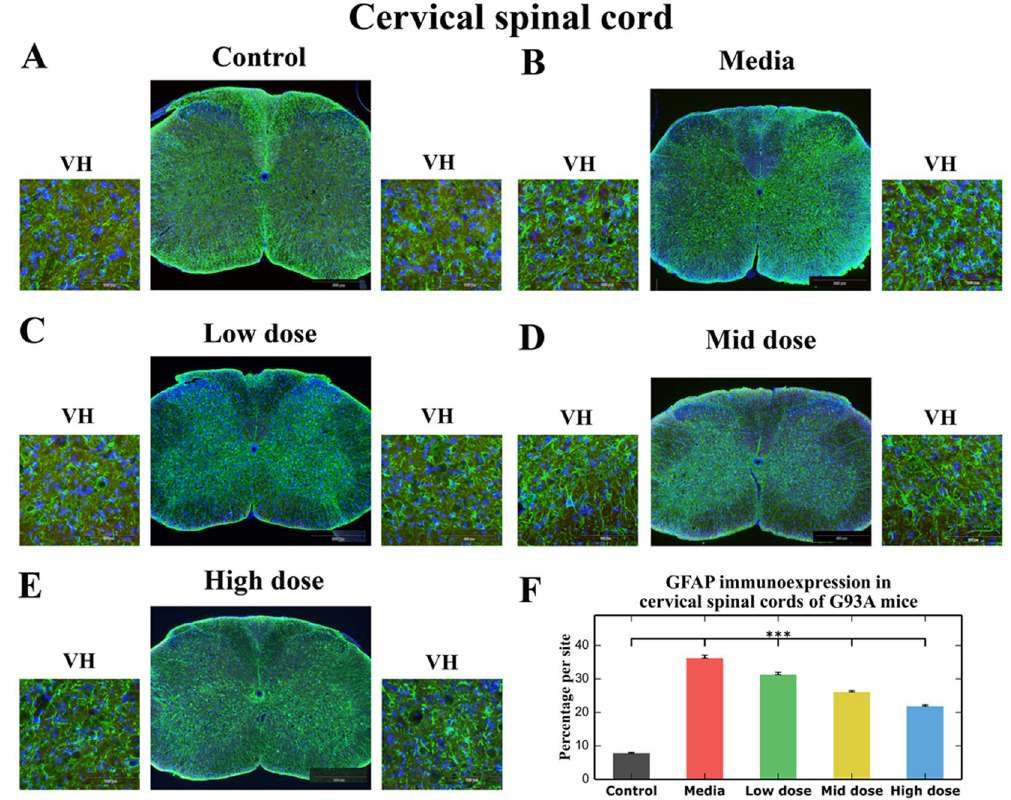
Figure 4. Characteristics of protoplasmic astrocytes in the cervical spinal cord of G93A mice. Immunohistochemical staining of astrocytes using GFAP antibody (green) in ( A ) control mice showed cells with normal cellular morphology distributed relatively uniformly within spinal cord gray matter. ( B ) At 17 wks of age, astrocytes with large cell bodies and hypertrophic processes at high density were determined in media-injected mice. ( C ) Moderate decrease of reactive astrocytes was noted in the ventral horns of ALS mice treated with low cell dose. ( D ) Less astrocyte cell reactivity and more astrocytes with thin cell processes were seen in the gray matter of ALS mice with mid dose. ( E ) Only a few astrocytes with thick cell processes and enormous cell bodies were found in mice after high cell dose transplantation. In these mice, more astrocytes with typical cellular morphology were noted. Scale bar in A-E for full coronal spinal cord section is 500 µ m and in ventral horn insert is 100 µ m. ( F ) Quantitative analysis of GFAP immunoexpression in the cervical ventral horn demonstrated significantly higher astrocyte density in media-injected mice vs. controls of the same ages. Significant decreases of GFAP immunoexpression were determined in all cell-treated compared to media- injected mice with greatest decrease in mice treated with high cell dose. *** p <